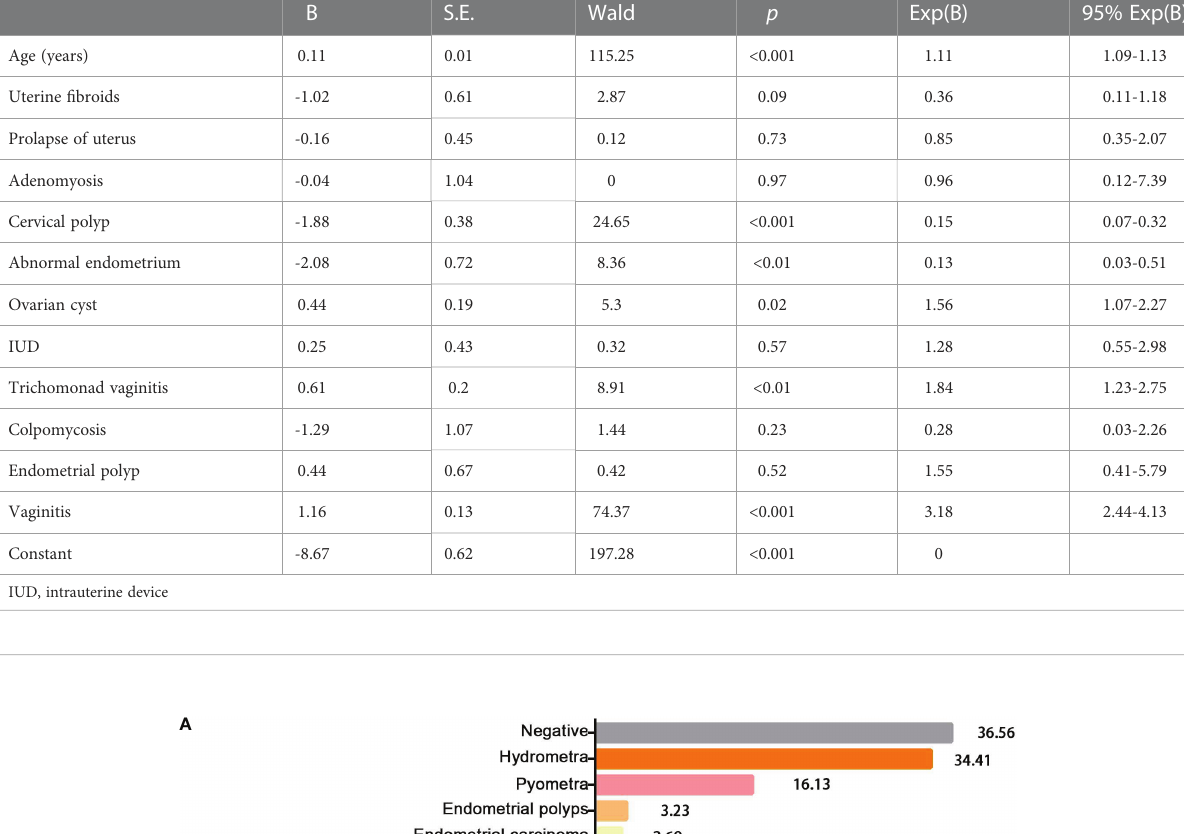
TABLE 2 Multivariate analysis of risk factors for hydrometra (sample size: 3903).